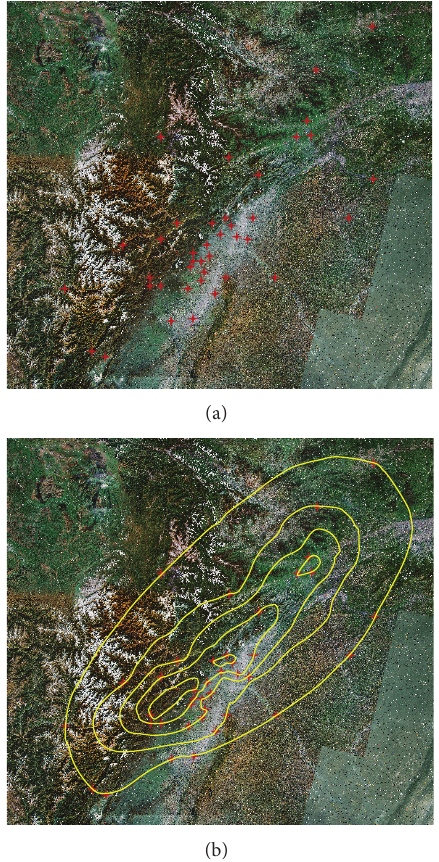
Figure 5: (a) Forty points labeled in remotely sensed satellite image; (b) isoseismal line based on forty discrete evaluation